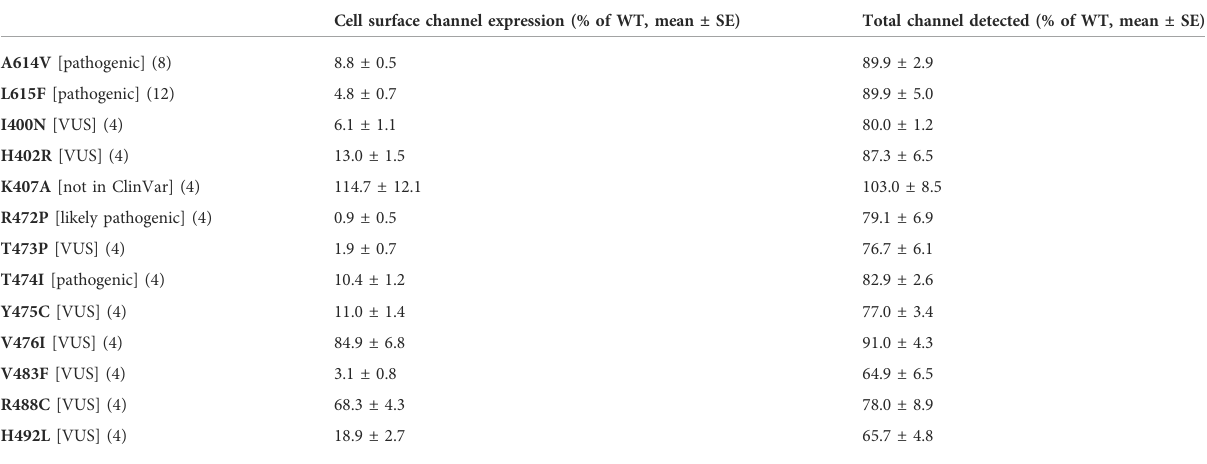
TABLE 4 Summary of traf fi cking results for hERG voltage sensor domain variants and